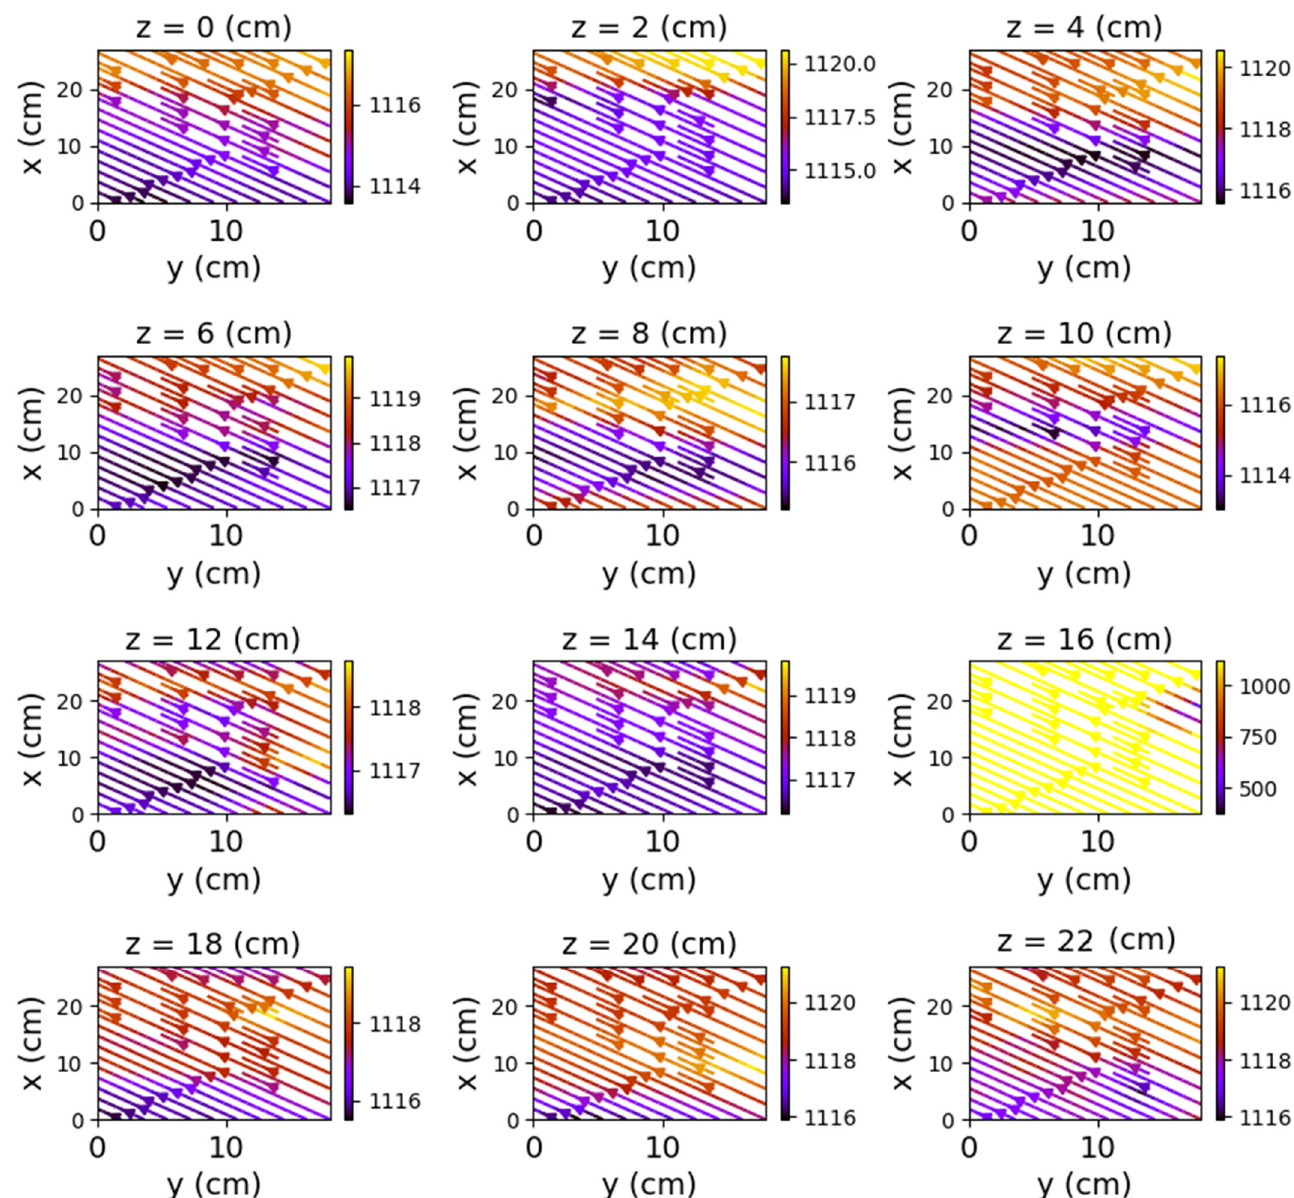
Figure 20. Field lines for x O y plane—relay with coil 2–4 powered.